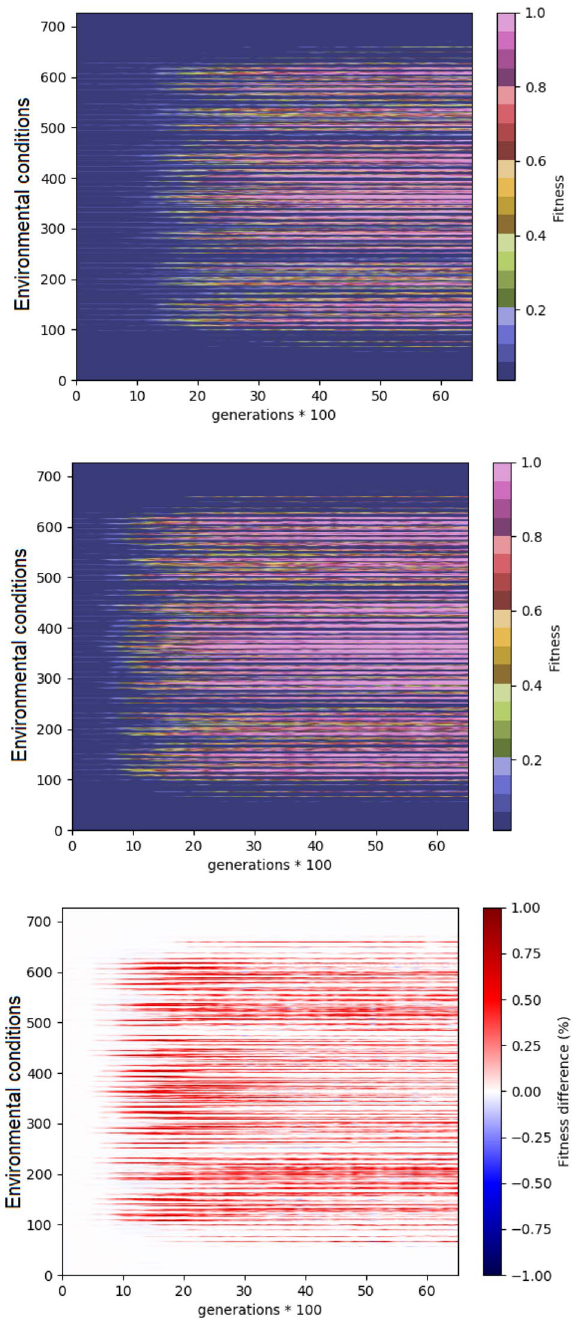
Figure 6. Heatmap of the performance for different environmental conditions during the evolutionary process. The vertical and horizontal axes indicate the environmental conditions and the generations, respectively. The top and central figures show the performance obtained in the experiment performed with the standard algorithm and with the curriculum learning algorithm with the cubic difficulty function. The bottom figure shows the difference between the performance obtained in the two conditions. Average results of 10 replications for each experimental condition. The figure is generated using python 3.6.7 https:// www. python. org/ downl